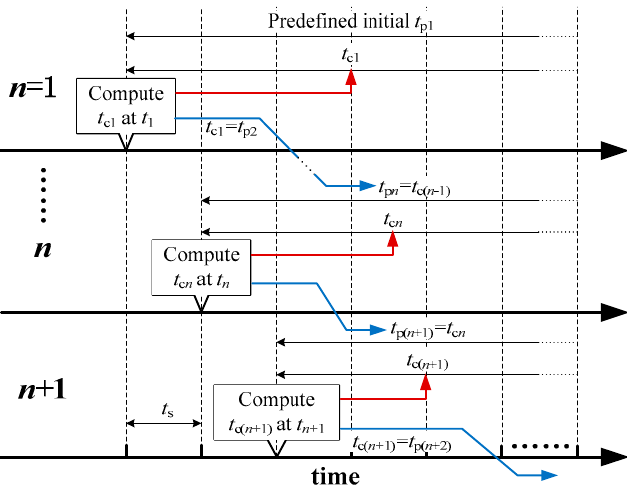
Figure 3. Determination of adaptive horizon parameters.